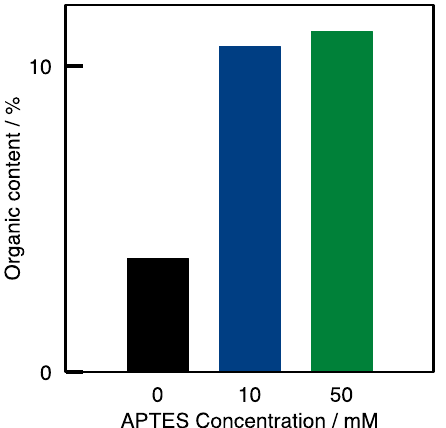
Figure 4. Relative organic content of Si(HIPE), TA-A10 and TA-A50 samples measured by TGA (relative mass loss over 150 °C).